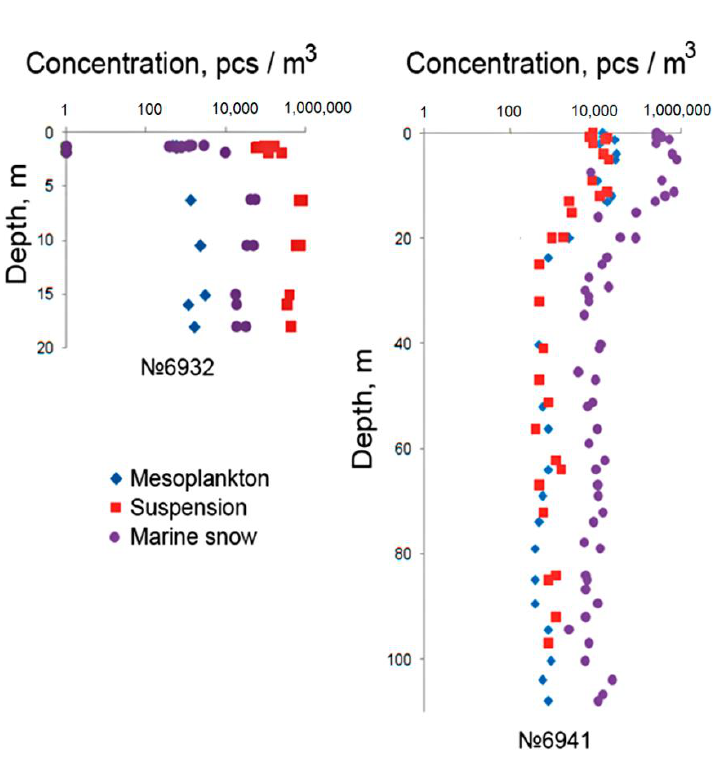
Figure 11. Distribution of Mesoplankton , Suspension , and Marine snow taxa concentrations at depth in various water areas of the Russian Arctic: No. 6932 — estuary of the Ob River; No. 6941 — Laptev Sea near pack ice. The abscissa scale (concentration) is indicated on a logarithmic scale for simplicity of representation.